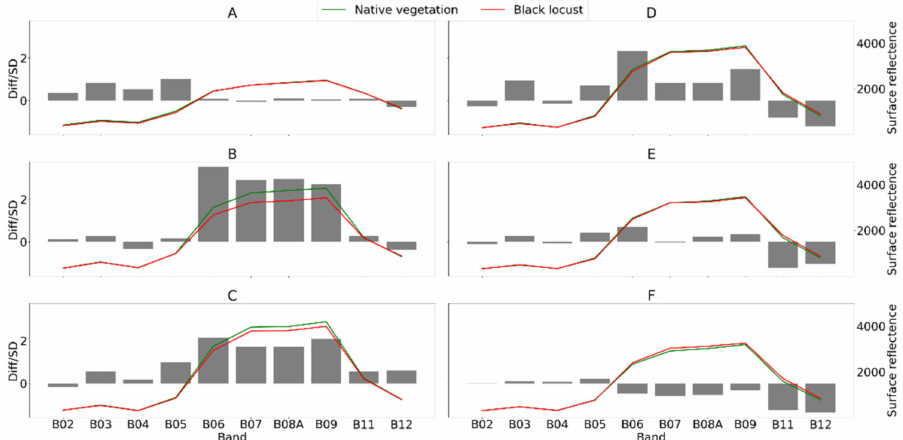
Figure 6. Spectral profiles (SR*10000) of black locust canopies (red) and native vegetation (green) in monthly composites ( A —April; B —May; C —June; D —July; E —August; F —September). Spectral profiles represent means of the 1500 training pixels per each class. Bars represent standardized differences between